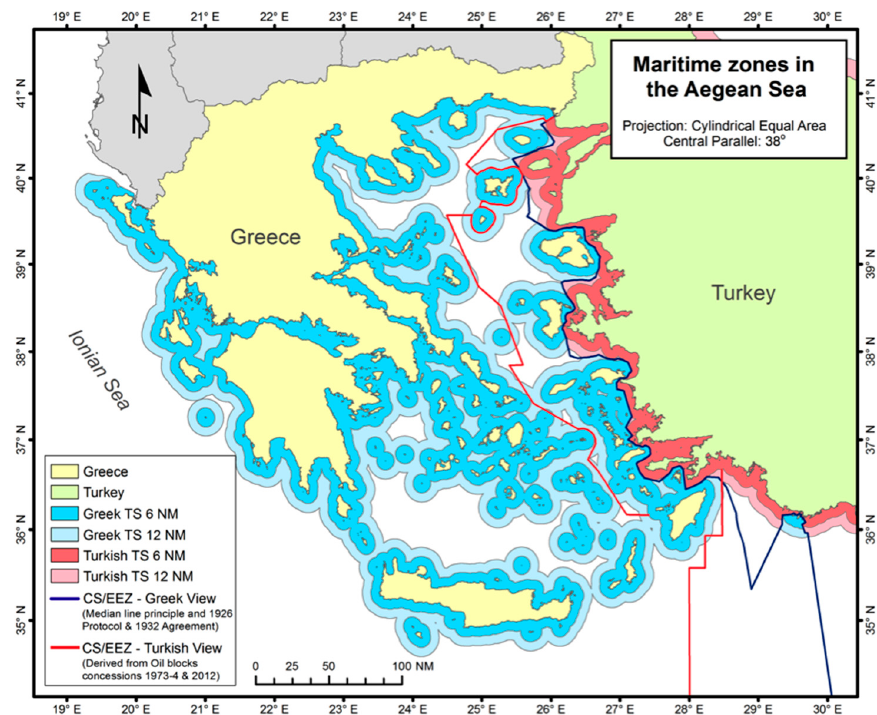
Figure 10. Greece’s territorial sea and potential Exclusive Economic Zone (EEZ), Continental Shelf in the Aegean Sea [49].